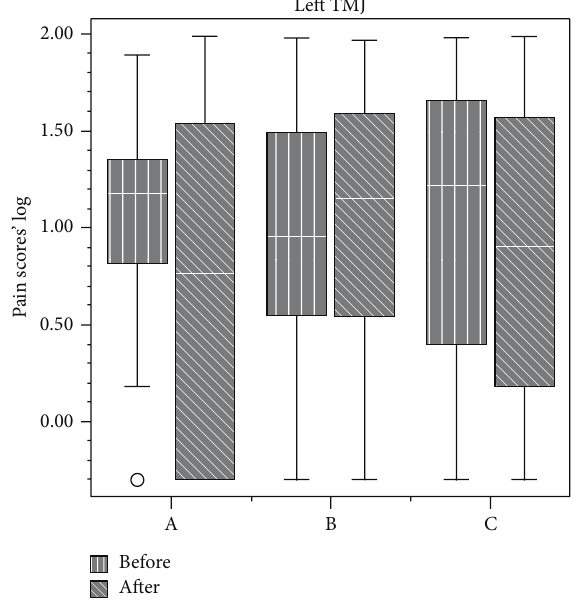
Figure 4: Pain scores (median and interquartile intervals) before and after treatment in the temporomandibular joint from groups A (NSAID—sodium diclofenac), B (panacea—sodium diclofenac + carisoprodol + acetaminophen + caffeine), and C